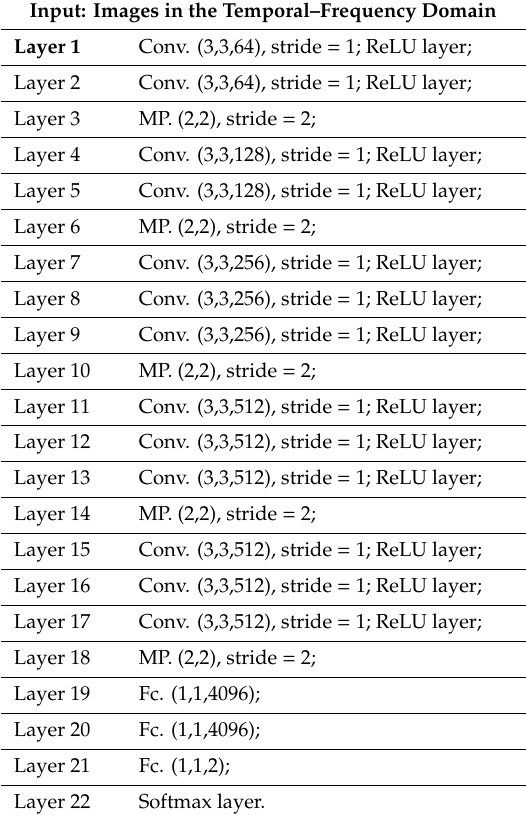
Table 1. IDN Architecture.